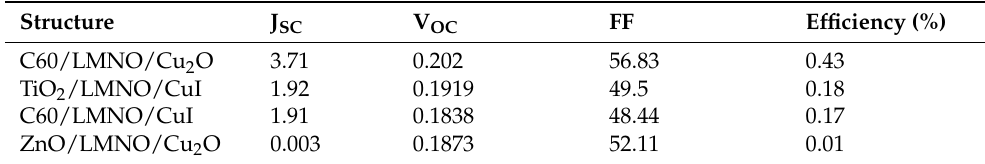
Table 3. Effect on efficiency and Voc with thickness.